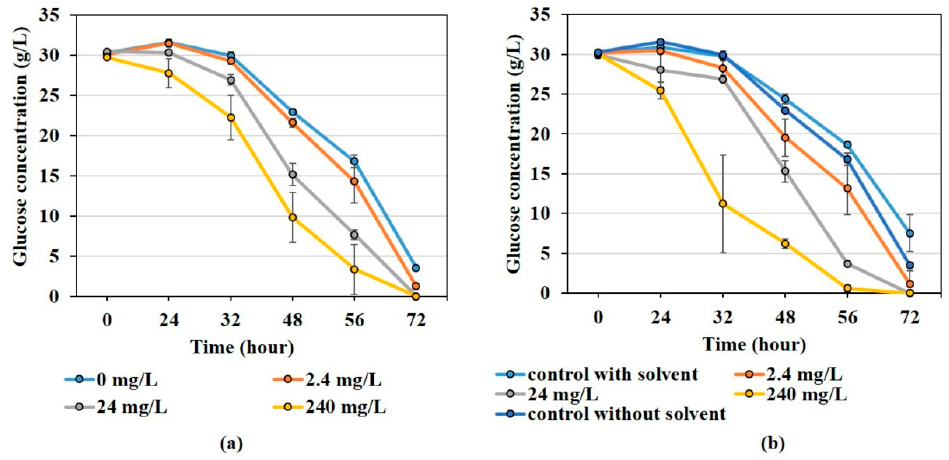
Figure 3. Glucose consumption of A. niger in bioactive-compound-added mediums. ( a ) Ellagic acid; ( b ) quercetin.